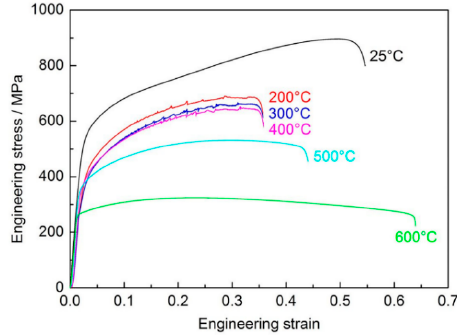
Figure 1. Engineering strain-stress curves at different tensile test temperatures of the experimental steel.